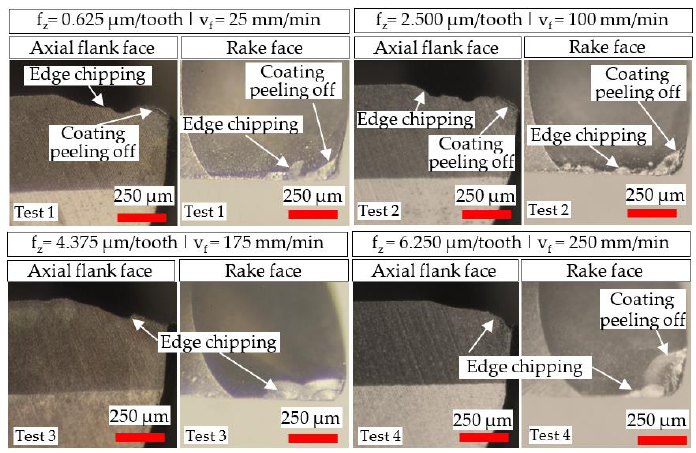
Figure 7. Tool wear micrographs for the Ø 4 mm end-mills at test cessation.